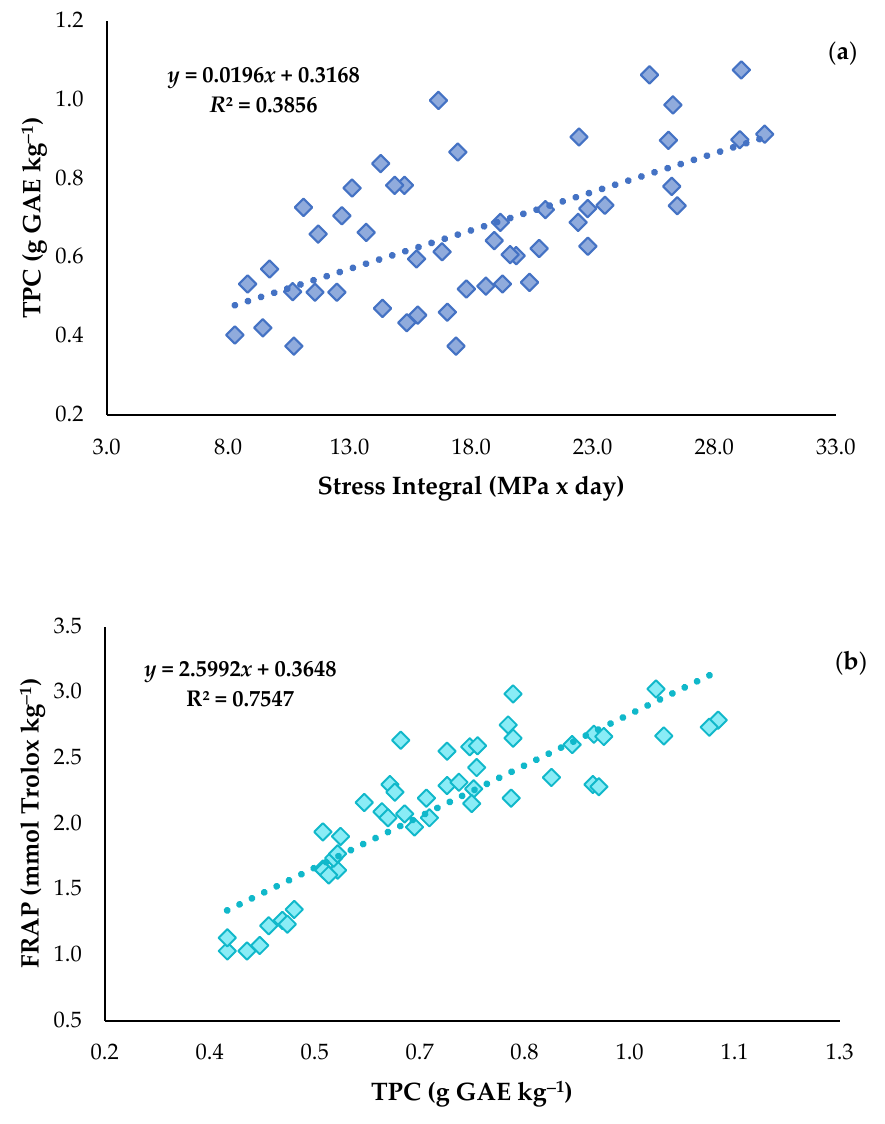
Figure 6. Quadratic correlation between: ( a ) Total phenolic content (TPC) and stress integral (SI) and ( b ) Antioxidant activity content (FRAP). Four repetitions per treatment were used for the correla- tion.